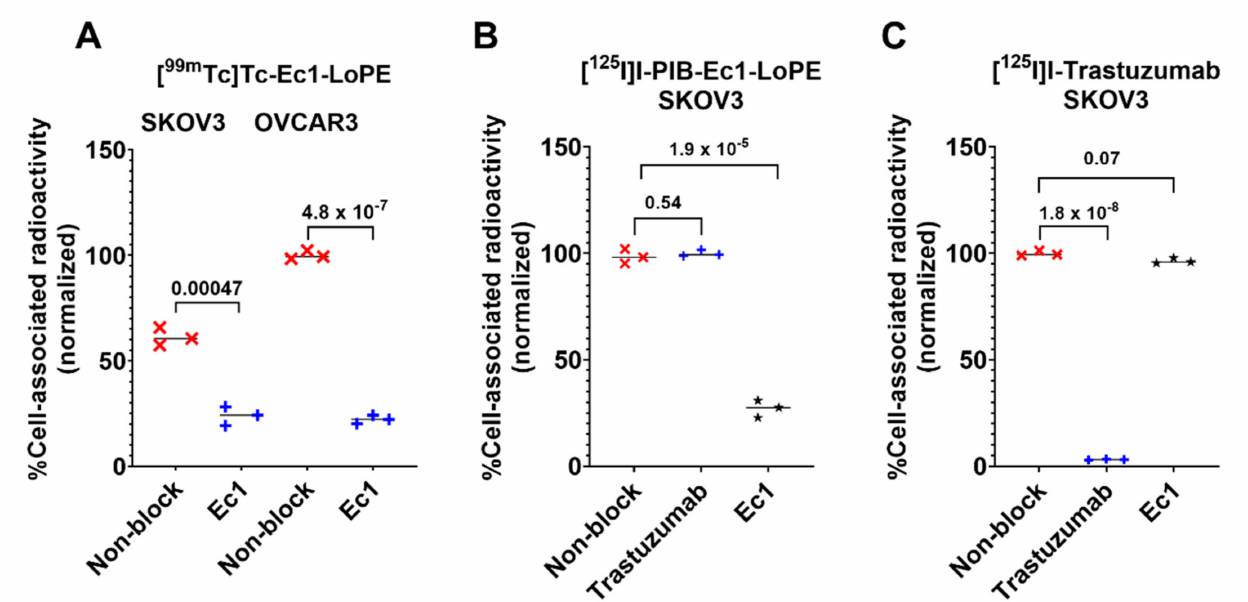
Figure 2. In vitro binding specificity of ( A ) [ 99m Tc]Tc-labeled Ec1-LoPE in SKOV3 and OVCAR3 cells expressing EpCAM; Symbols ( × ) show individual measured values for binding to non-blocked cells, and symbols (+) measured values for binding to blocked cells. ( B ) cross-blocking study of [ 125 I]I-labeled Ec1-LoPE; and ( C ) [ 125 I]I-labeled trastuzumab in EpCAM- and HER2-expressing SKOV3 cells. For blocking, a 100-fold molar excess of anti-EpCAM DARPin Ec1 or anti-HER2 antibody trastuzumab was added to blocked groups. The final concentration of radiolabeled compound was 2 nM. The data are presented as average ± SD ( n = 3). p -values from unpaired t -test (equal variation) are provided to characterize differences between activity uptake in blocked and non-blocked groups. Symbols ( × ) show individual measured values for binding to non-blocked cells, symbols (+) measured values for binding to cells blocked with trastuzumab, and symbols ( (cid:70) ) measured values for binding to cells blocked with